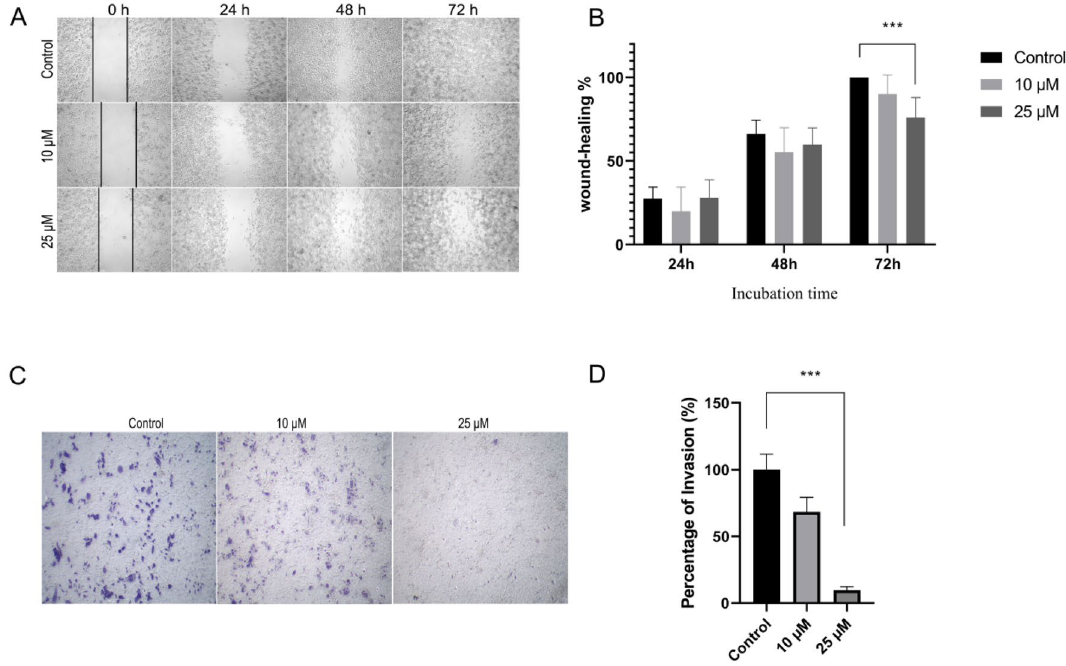
Figure 2. Zn{[CH 3 ) 3 C] 2 Sal} 2 2− inhibits 4T1 cell migration and invasion. ( A ) With 10 and 25 μM Zn{[CH 3 ) 3 C] 2 Sal} 2 2− treatment, 4T1 cell migration ability was determined by wound healing assay at 0 h, 24 h, 48 h, and 72 h. ( B ) Statistical analysis of the wound healing assay of three independent experiments. Error bars represent the mean ± SEM, *** P < 0.001. C) The invasion ability was determined by a Transwell invasion assay after 22 h incubation. ( D ) Statistical analysis was performed with three independent Transwell invasion assays. Error bars represent mean ± SEM. *** P <